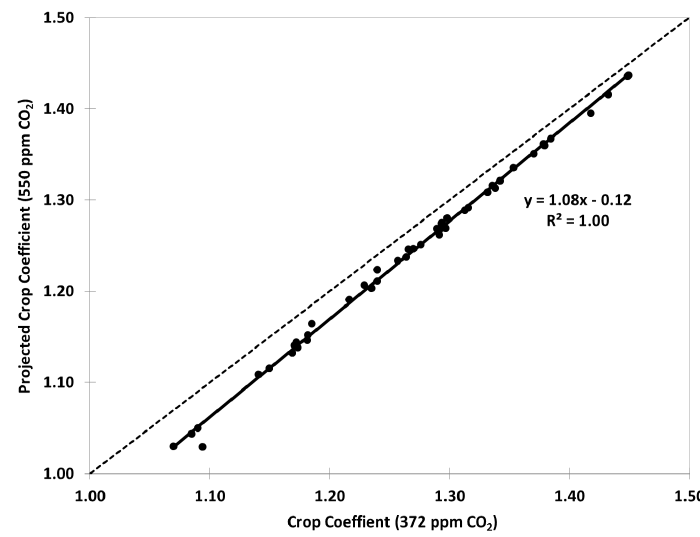
Figure 2. A plot of K c values for alfalfa calculated from July 2003 mean daily weather data from 49 CIMIS weather stations in California for a climate with 550 ppm versus 372 ppm CO 2 . For the projected 550 ppm CO 2 climate, the original daily maximum temperature data were increased by 2 ◦ C, and the minimum and dew point temperatures were increased by 4 ◦ C relative to July 2003 data. The wind speed and solar radiation were not changed from the original data. The alfalfa ET c was computed using the ET r equation (Equation (9)), and ET o was computed using Equation